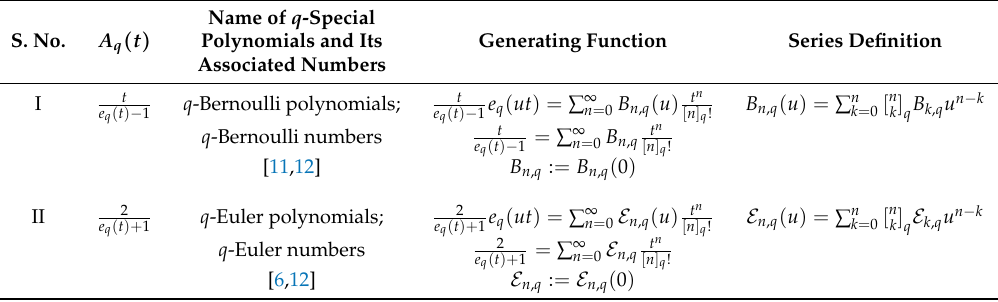
Table 1. Certainmembers belonging to the q -Appell